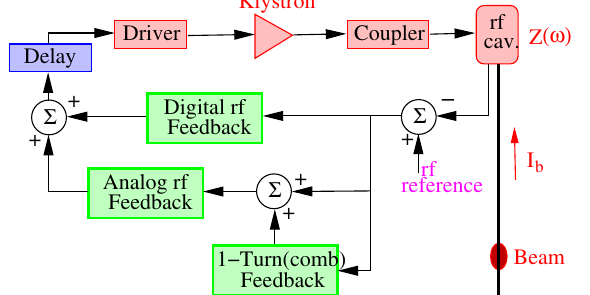
FIG. 2. Rf loop model block diagram with detailed llrf.